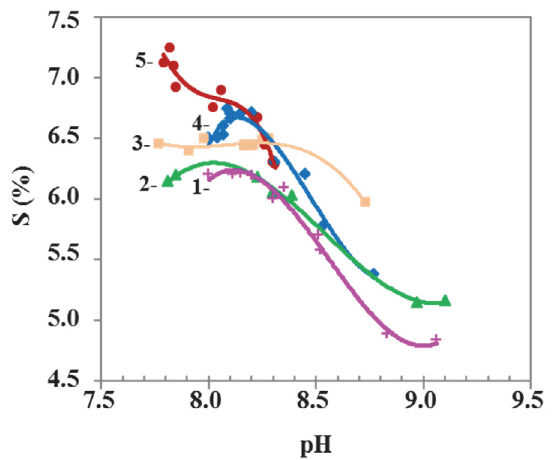
Figure 9 . Interaction between sulfur contained in the BNC and pH suspension, industrial process (Stage 03). 1.60≤NH 3 /CO 2 <1.80.